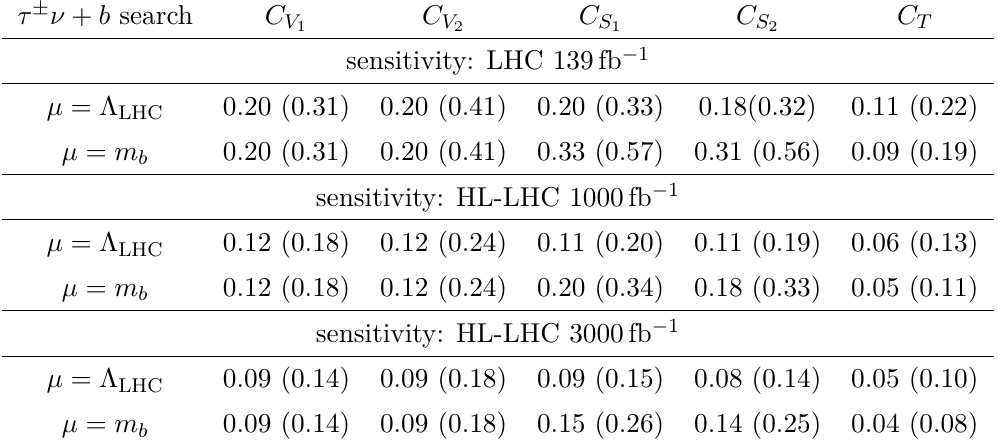
Table 6 . Same as table 5 but for cut b (the τ ± ν + b